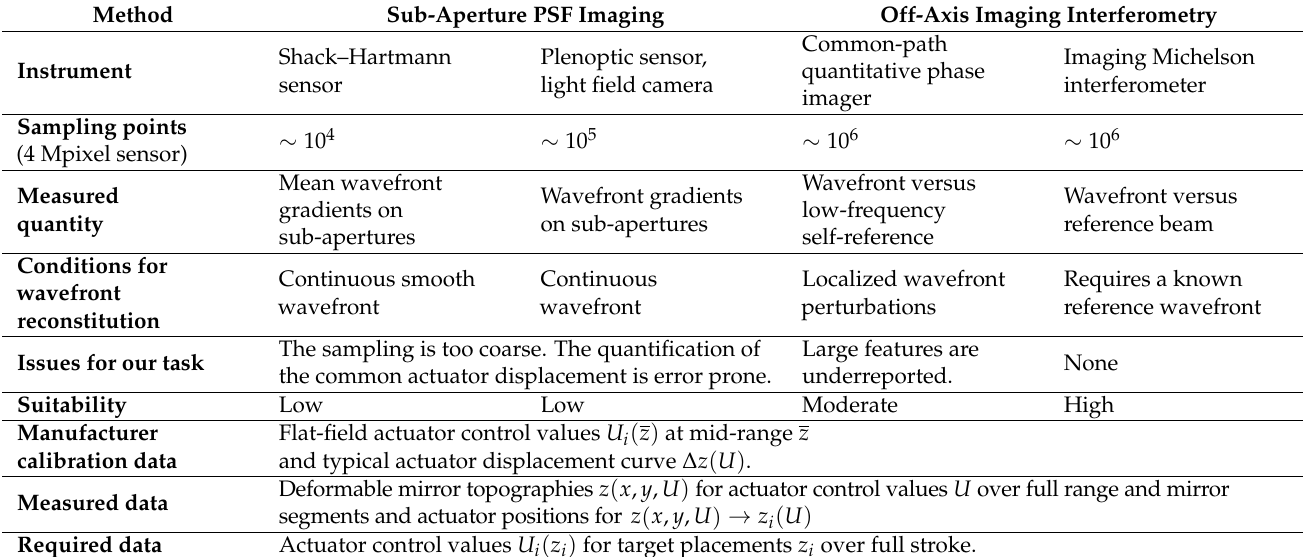
Table 1. Comparison of the considered wavefront measurement methods and calibration data.